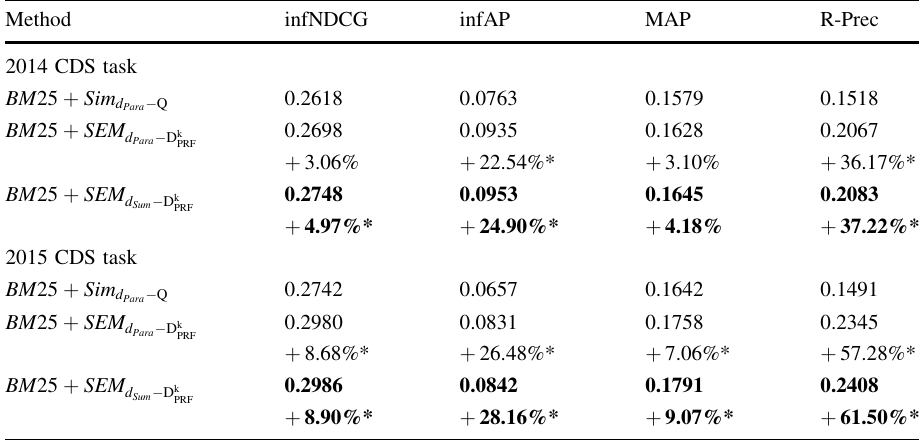
The results are obtained based on the Summary field